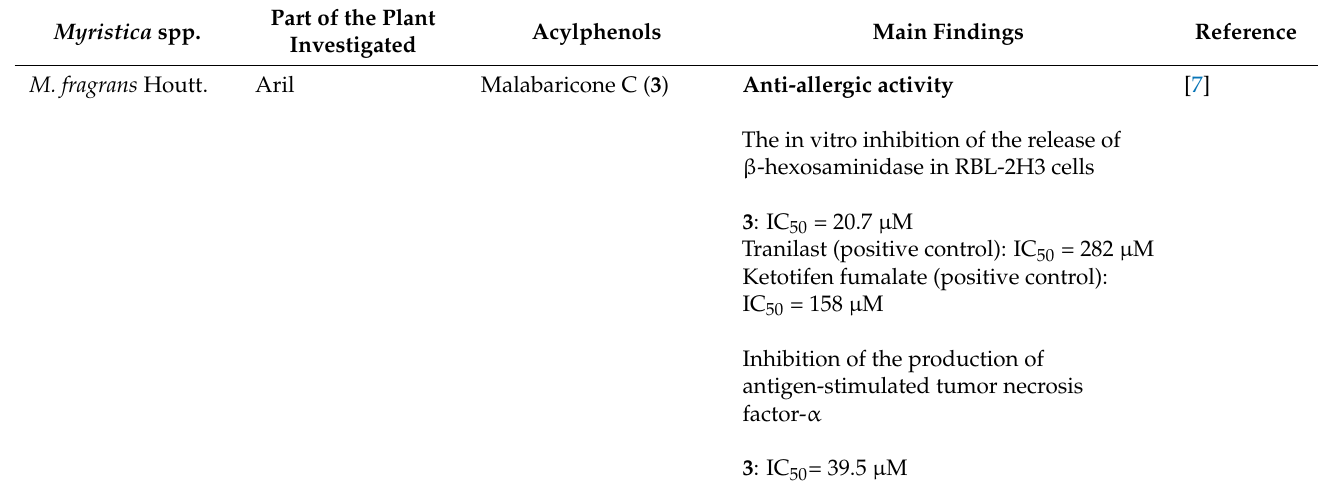
Table 9. The anti-allergic activity of acylphenols from the genus Myristica . Myristica